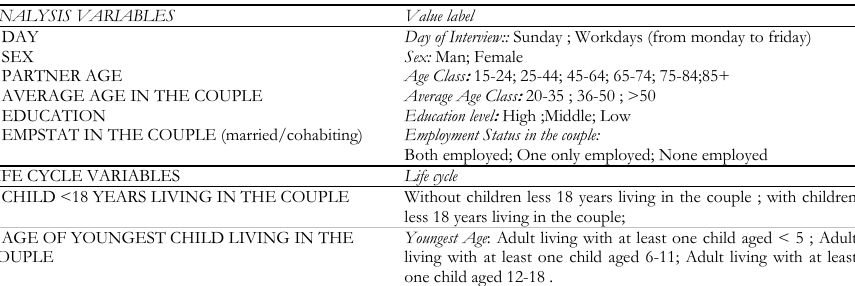
Analysis Variables and Life Cycle Variables for the set N = 22 macro-cases ANALYSIS